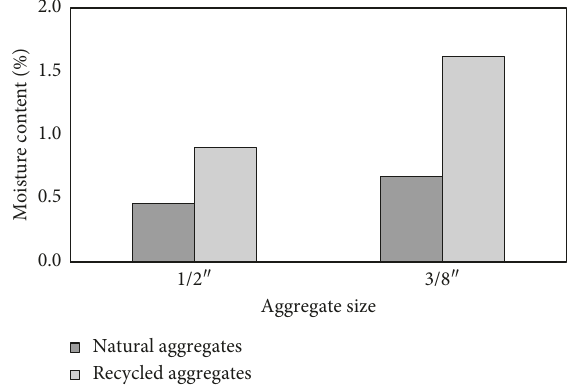
Figure 9: Moisture content of natural and recycled aggregates.